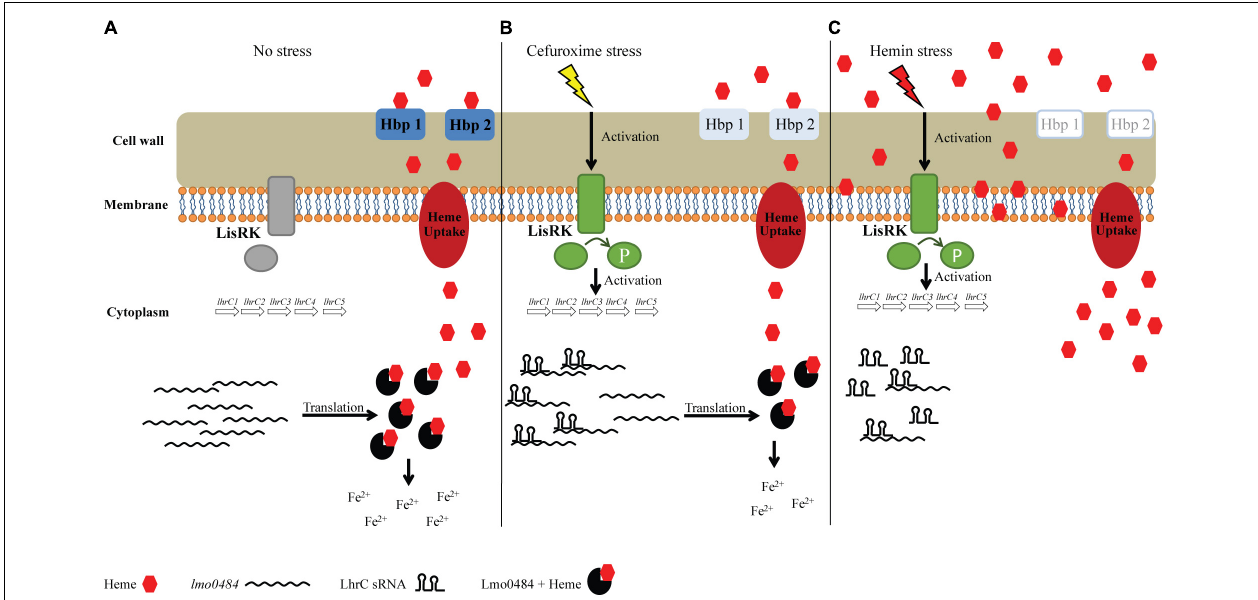
FIGURE 9 | Proposed model of the regulatory effect of LhrC1–5 on heme uptake and utilization genes. (A) During growth in BHI medium, there is no activation of the TCS LisRK and subsequently LhrC1–5 are not induced. Under this condition, lmo0484 , lmo2186, and lmo2185 are expressed and heme-uptake from the BHI medium is taking place according to the cells’ needs. The lmo0484 mRNA is translated into a IsdG-like heme oxygenase, which will catalyze the degradation of heme to obtain free iron. (B) When the cells are subjected to cefuroxime stress, LisRK will be activated. LhrC1–5 are then induced and can bind lmo0484 mRNAs. Binding of LhrC sRNA to the SD region of lmo0484 mRNA leads to inhibition of translation. Under cefuroxime stress, LhrC1–5 most likely act to control the expression of the heme uptake genes lmo2186 and lmo2185 in a similar fashion (not shown). Thus, when exposed to cefuroxime, LhrC1–5 act to fine-tune the expression of heme uptake and utilization genes, suggesting a need for L. monocytogenes to slightly reduce the uptake of heme when the cell envelope is being stressed. (C) Under hemin stress, LhrC1–5 are strongly induced as well in a LisR-dependent manner. Furthermore, when the cell faces high concentrations of heme, the mRNA levels of lmo0484 are almost immediately diminished by an unknown mechanism. In this situation, LhrC1–5 will bind the remaining lmo0484 mRNAs in the cell and act as ‘vacuum cleaners’ to avoid translation of the residual lmo0484 mRNA. The heme uptake genes lmo2185 and lmo2186 are most likely controlled by heme and LhrC1–5 in a similar fashion (not shown). Consequently, the expression of heme acquisition genes is quickly reduced in response to heme stress to avoid further uptake of heme and liberation of